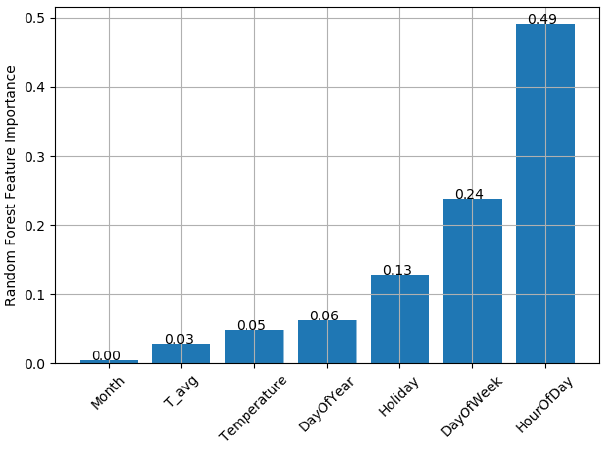
Figure 9. Data features importance in the random forest regression of the real data series.